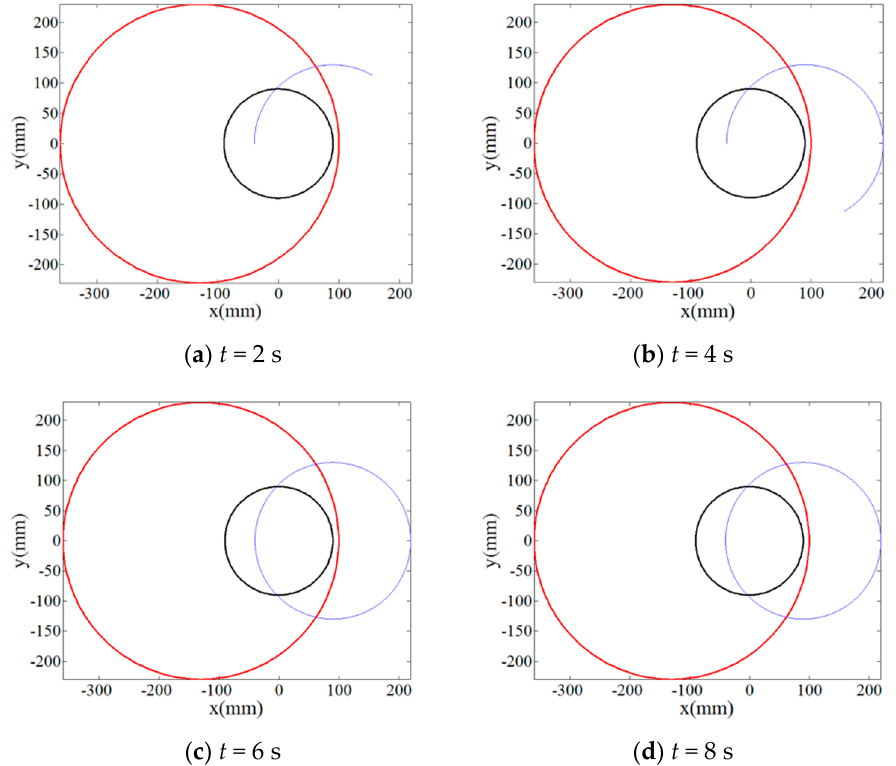
Figure 2. Relationship between trajectory of the single abrasive particle on target surface at i pw = 1 and lapping time ( a ) t = 2 s; ( b ) t = 4 s; ( c ) t =6 s; ( d ) t = 8 s (red lines represent the profile of the lapping plate, black lines represent the profile of the workpiece, and blue lines represent the trajectory of the single abrasive particle on the target